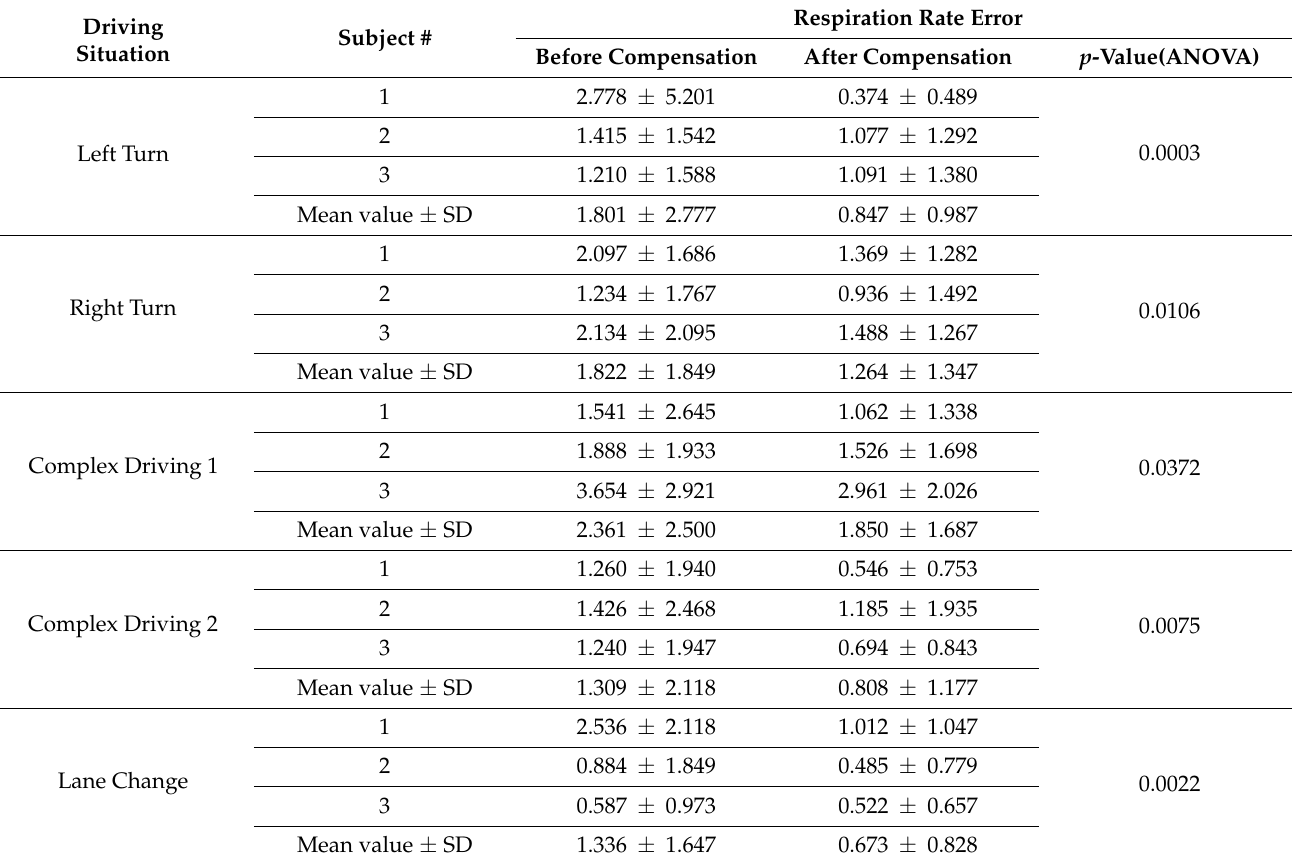
Table 2. Respiratory rate accuracy analysis according to each driving